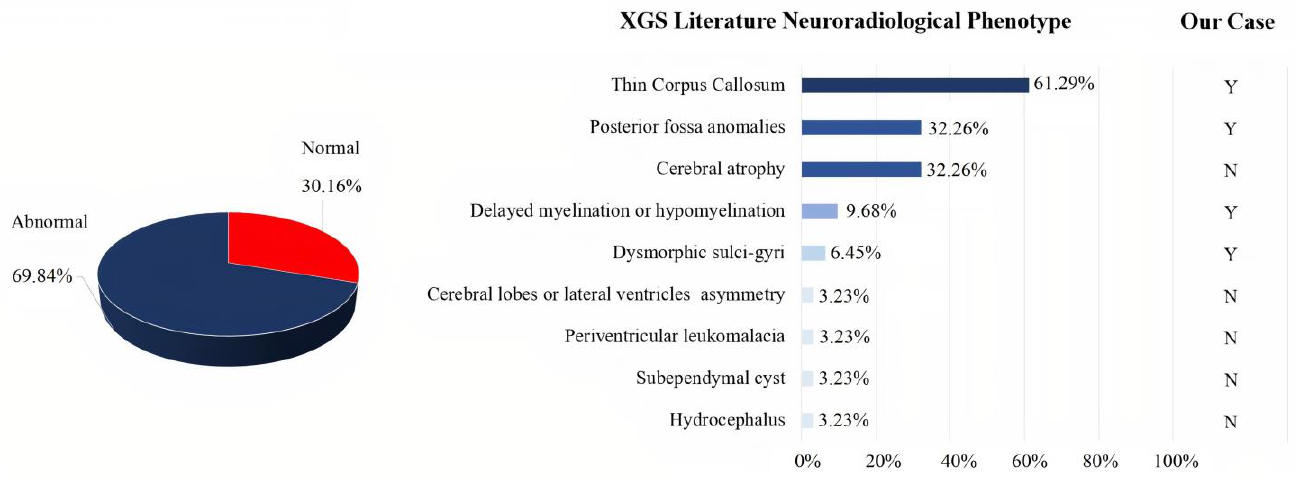
Figure 4. XGS neuroradiological findings in patient from the literature. Among a total of 63 patients with at least one brain MRI, 19 exhibited normal and 44 abnormal findings (pie chart). A detailed description of the literature brain MRI findings was only available for 31 of the 44 patients with abnormal findings in neuroimaging (bar graph). On the right-hand side, a comparison of our patient with literature data. Y: yes. N: not present.